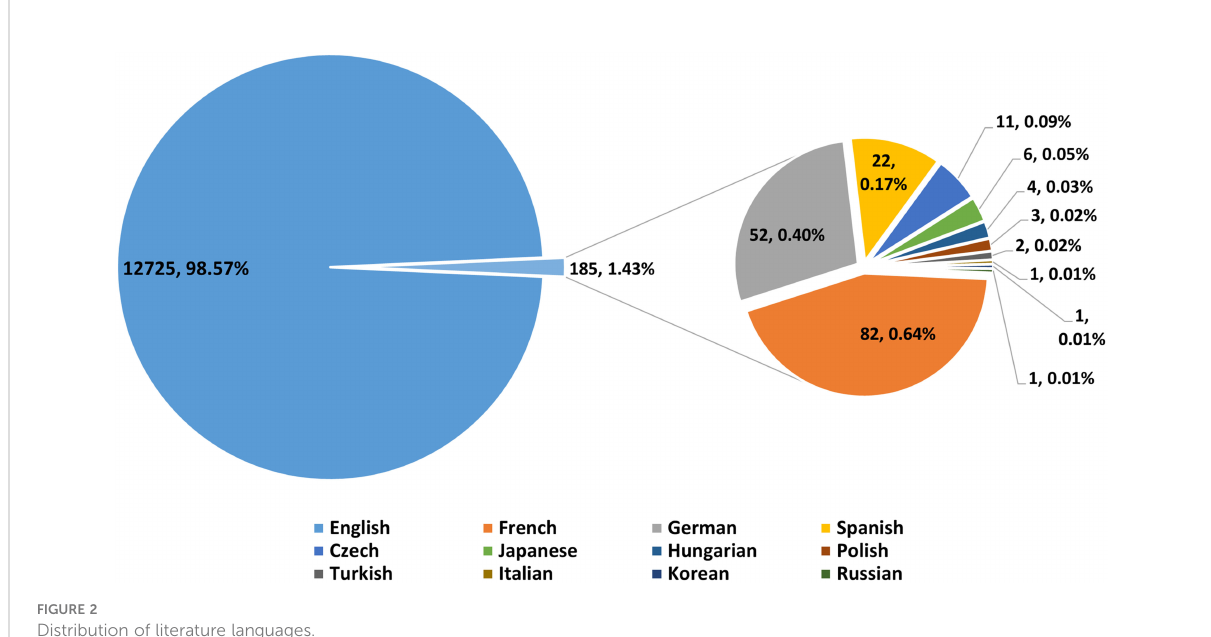
FIGURE 2 Distribution of literature languages.